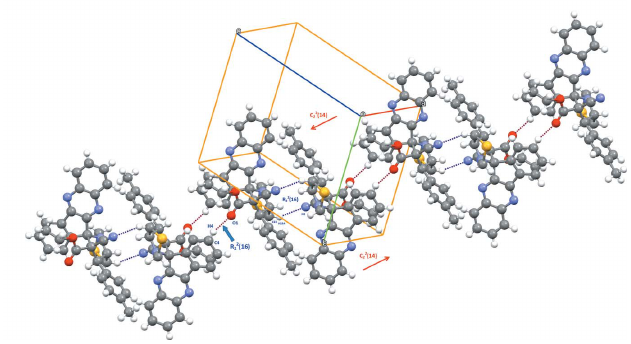
Figure 4 Two centrosymmetrically related R 2 (16) ring motifs and two C 22 (14) 2 chain motifs running in opposite directions formed by C—H (cid:3)(cid:3)(cid:3) N and C— H (cid:3)(cid:3)(cid:3) O interactions. Hydrogen bonds are shown as dashed lines. The minor component of the disordered –CH 3 group (C20 atom) is omitted for clarity.